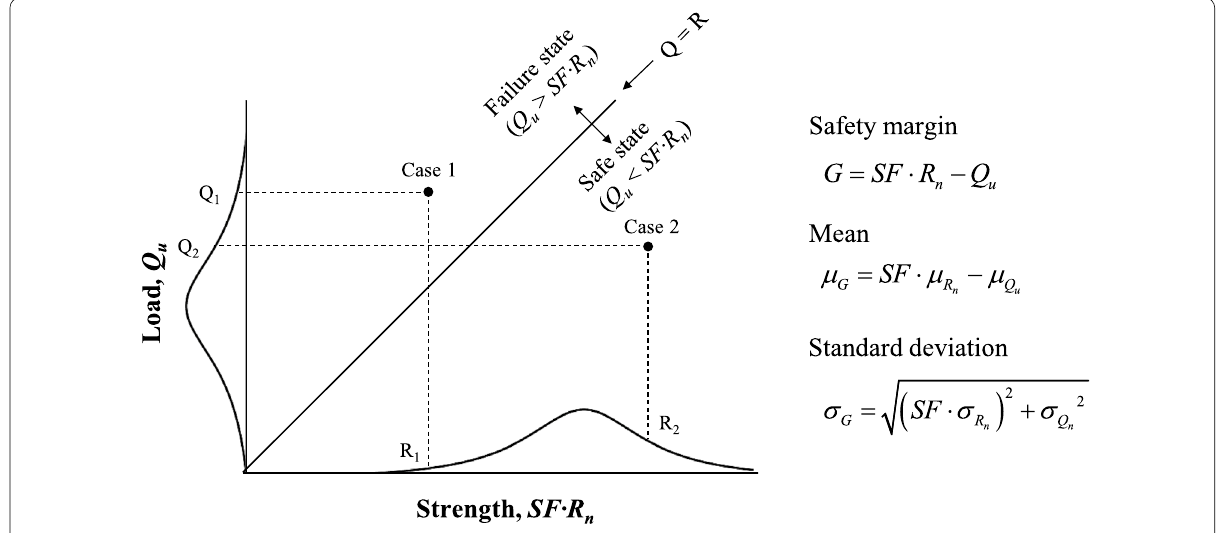
Fig. 3 Stractural reliability theory